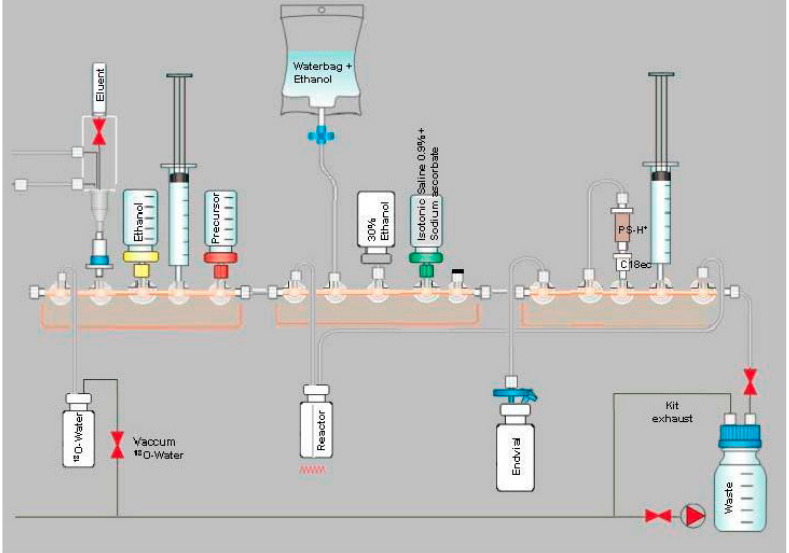
Figure 8. General setup of the radiosynthesiser for one-step production of [ 18 F]PSMA-1007 with SPE cartridge purification on GE TRACERlab MX and the NEPTIS mosaic-RS system.